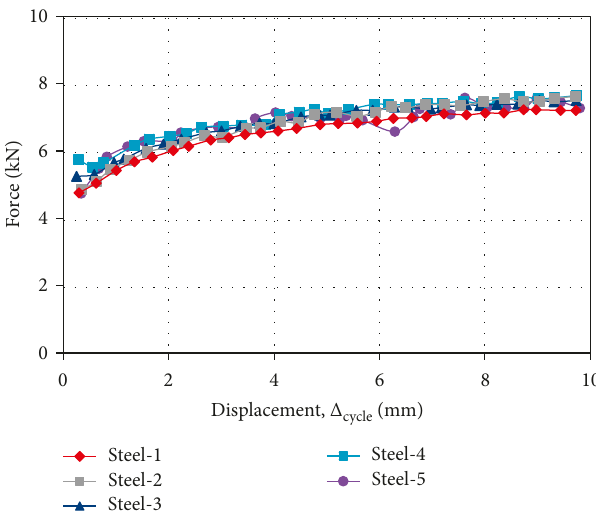
Figure 21: Comparison for loading forces along the measurement displacement loading cycles (steel material model series).